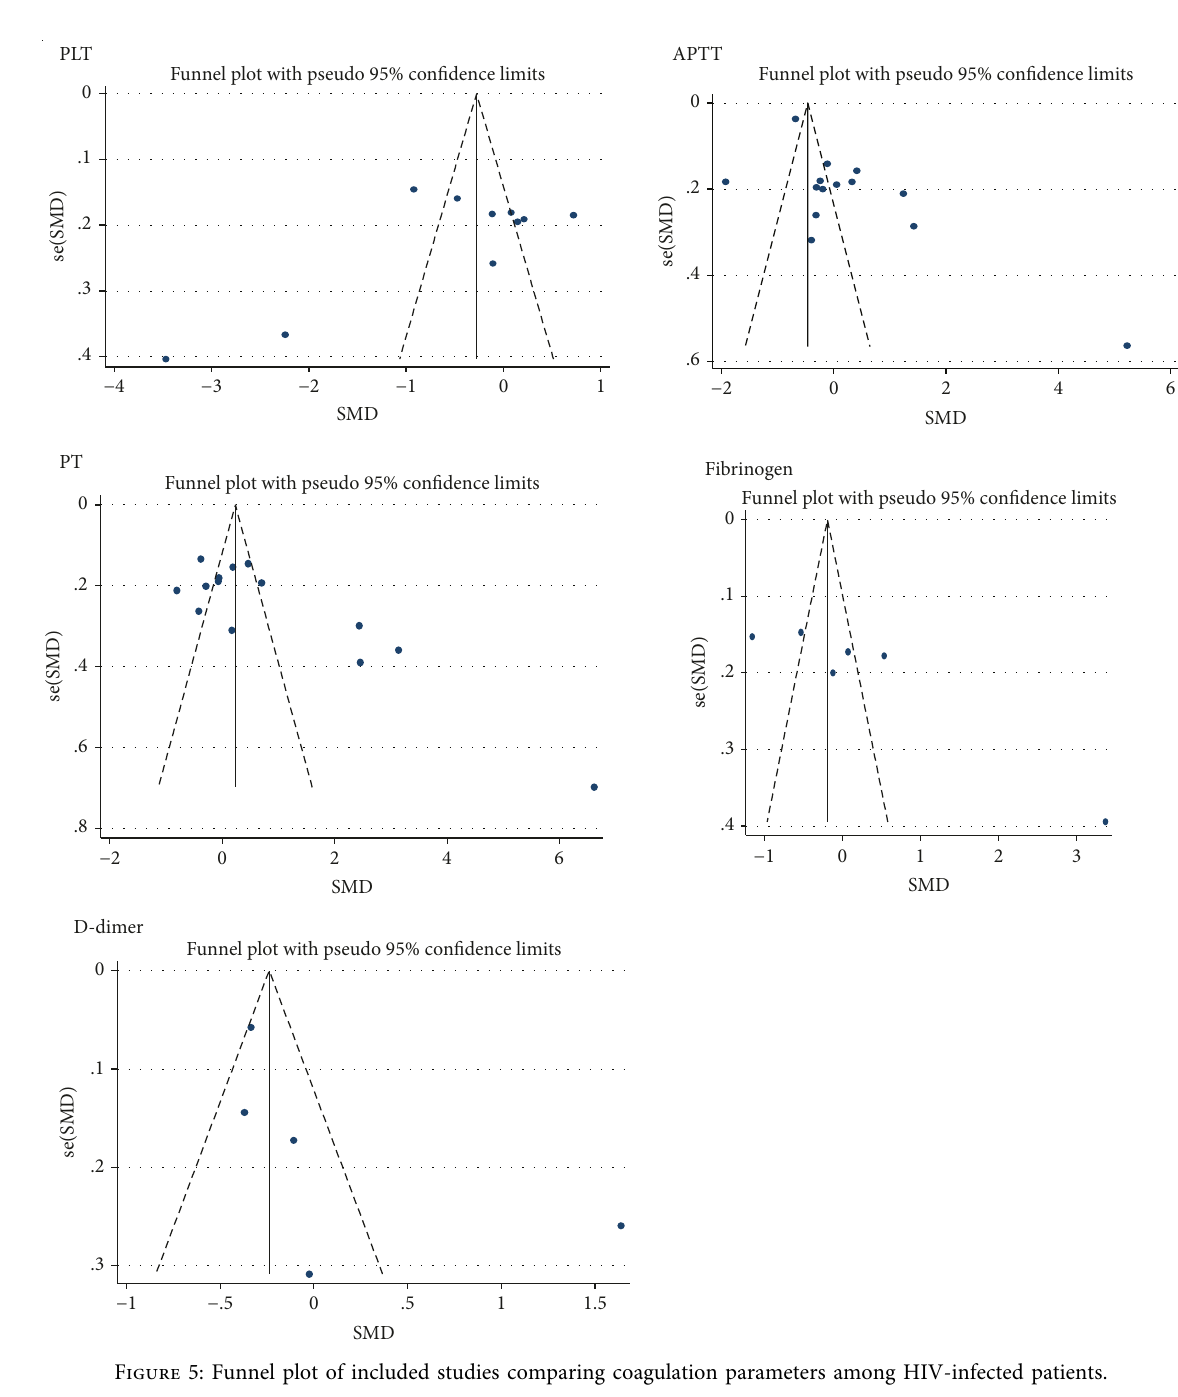
Figure 5: Funnel plot of included studies comparing coagulation parameters among HIV-infected